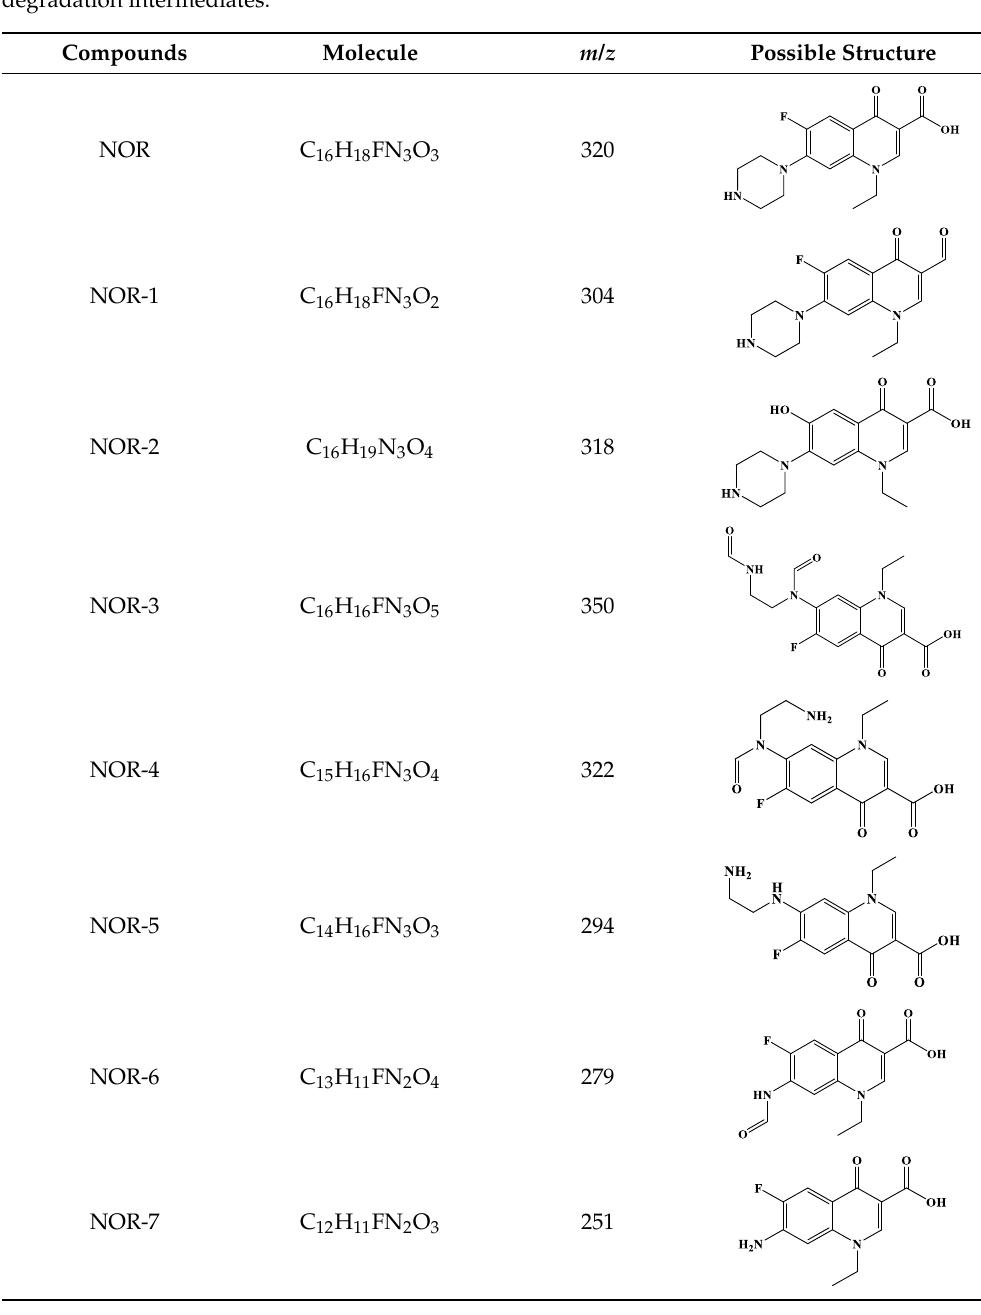
Table 1. The relative molecular weights and possible structural formulae of the NOR photo-degra- dation intermediates.